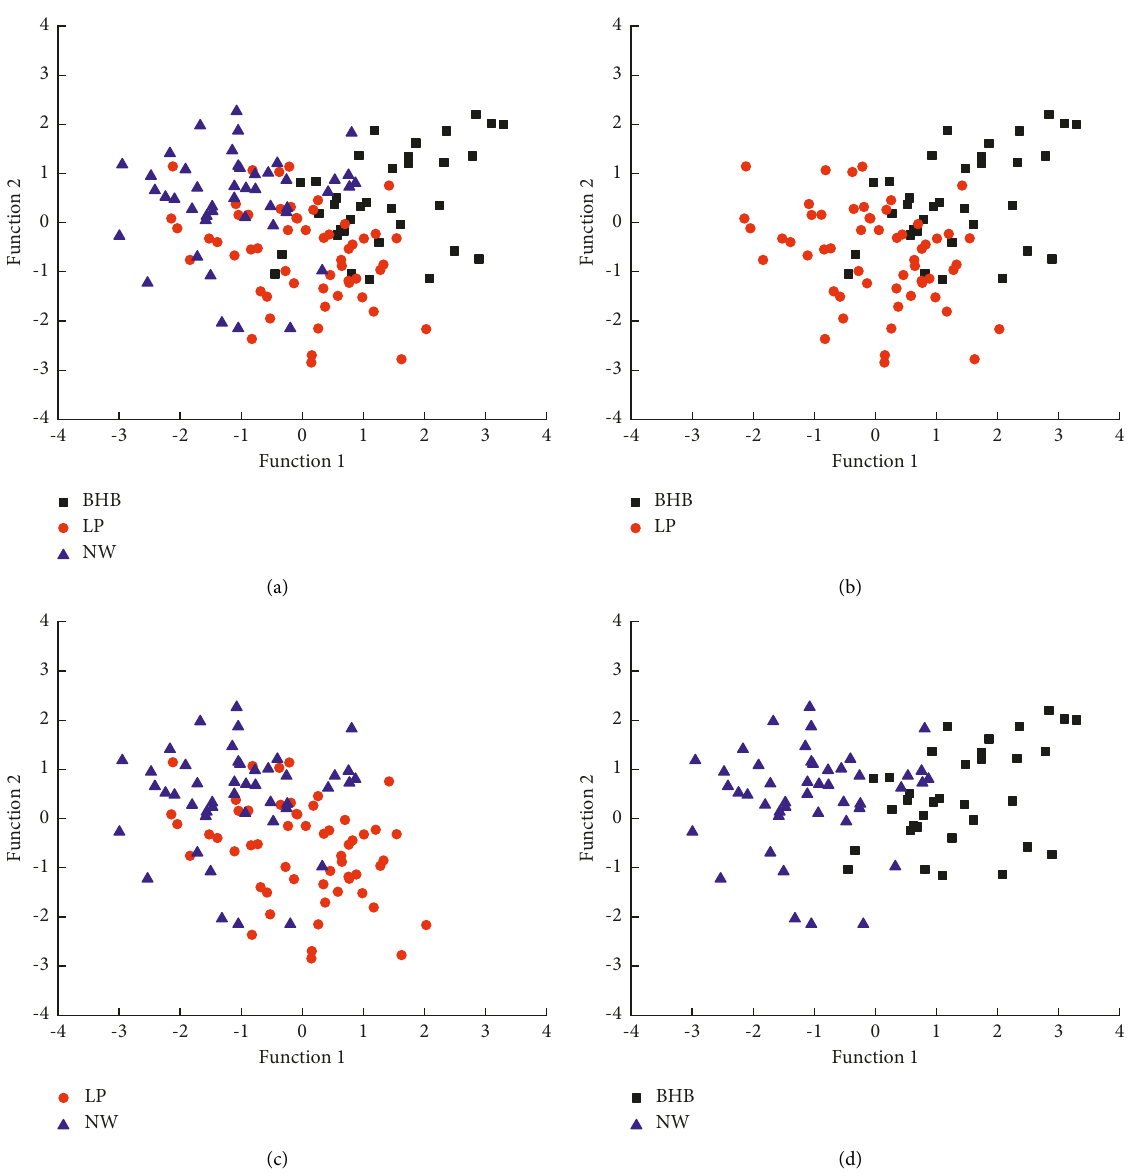
Figure 3: Scatter plot of the scores of apple samples from the three major apple-producing areas on the canonical discriminant